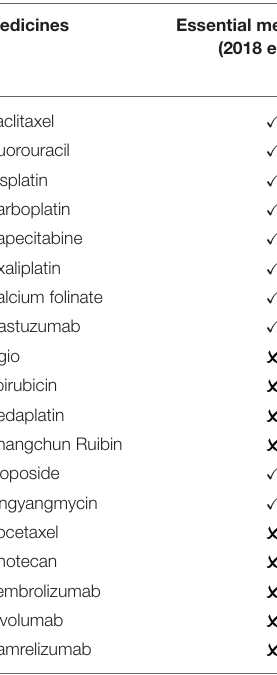
TABLE 3 | Medicines in the list and guidelines for the treatment of esophageal